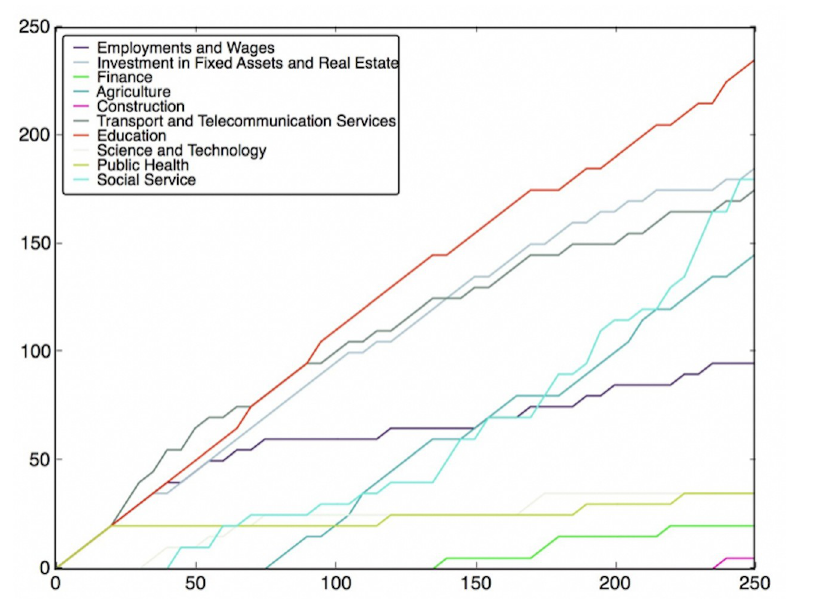
Fig 18. NNR with 5 features and genetic algorithm.